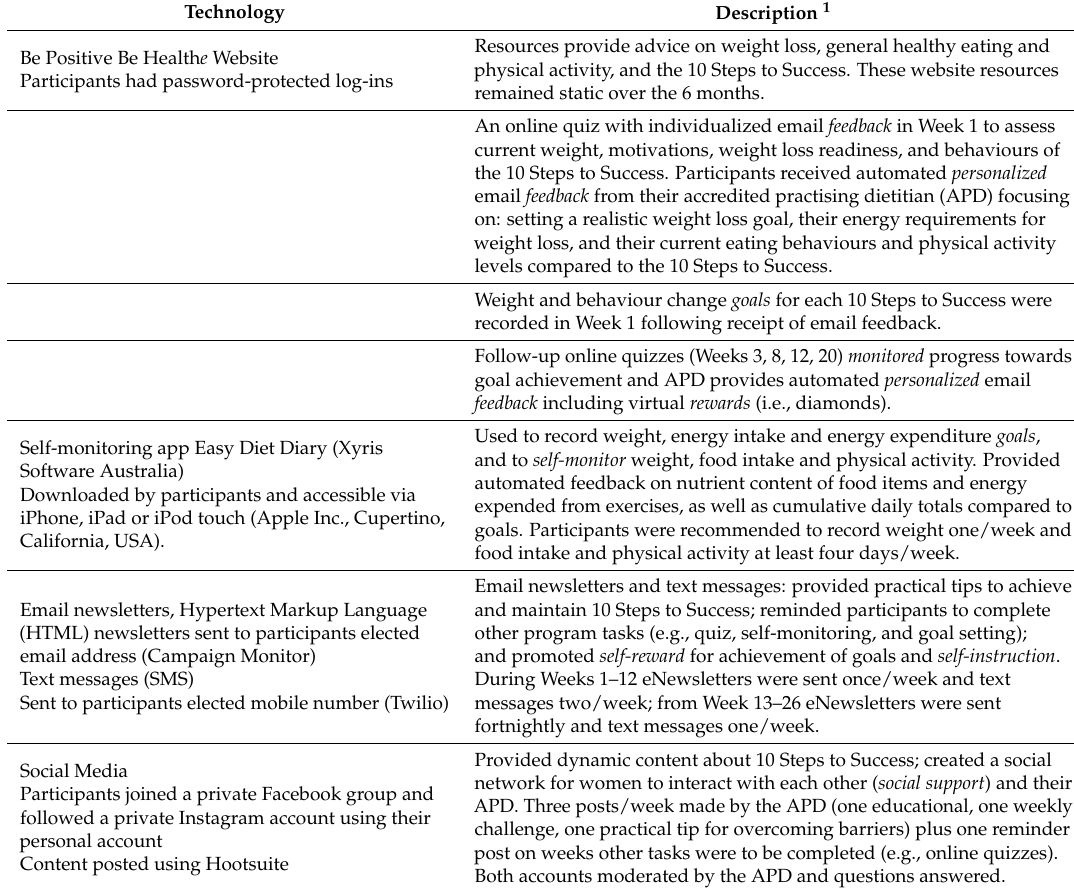
Table 1. Description of the Be Positive Be Health e six-month weight loss program